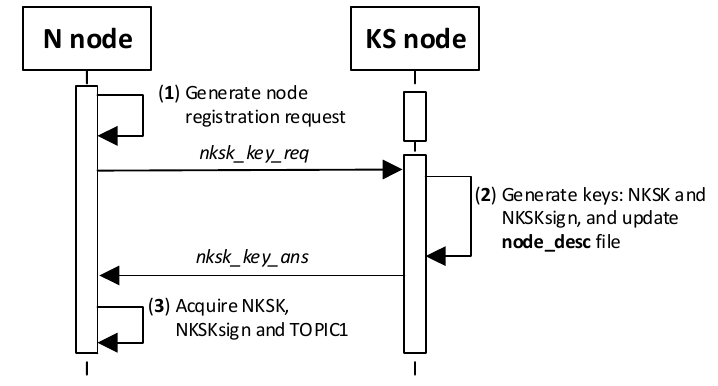
Figure 12. The way the KS node and N node work together during the procedure for registration of the N node.